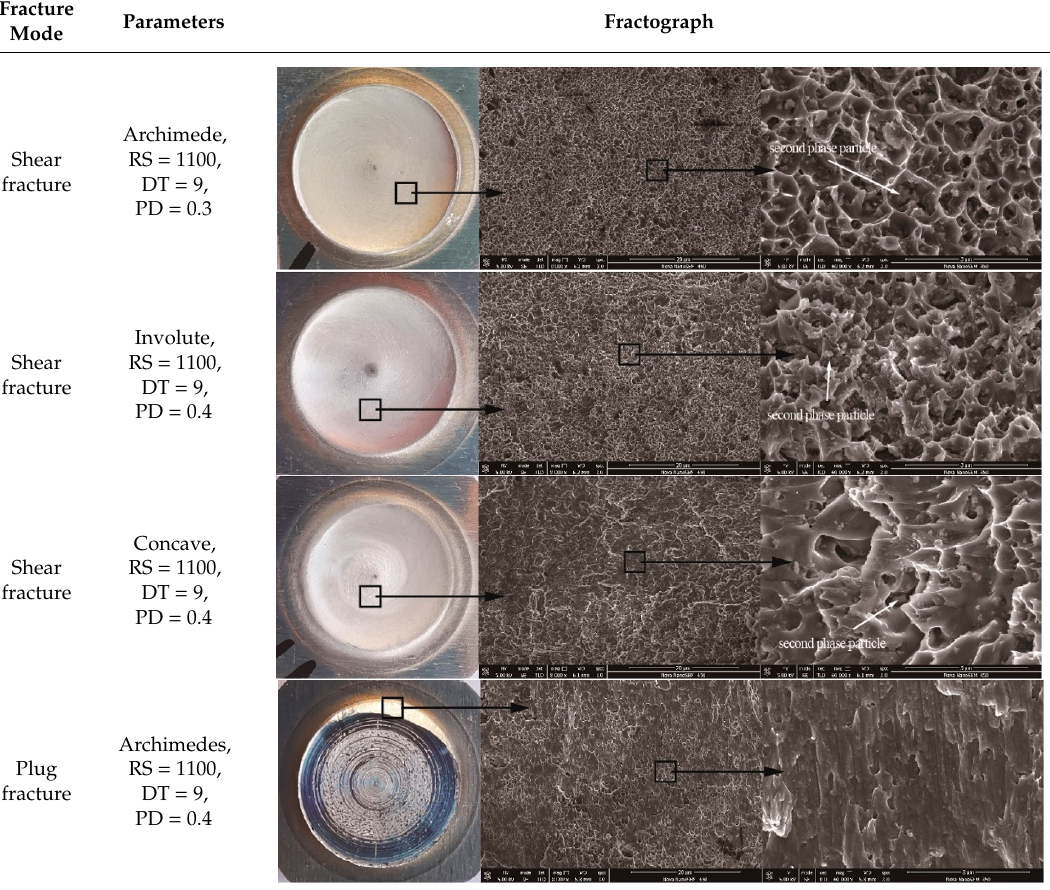
Table 3. Fractographs of the di ff erent facture modes in the bottom sheets.